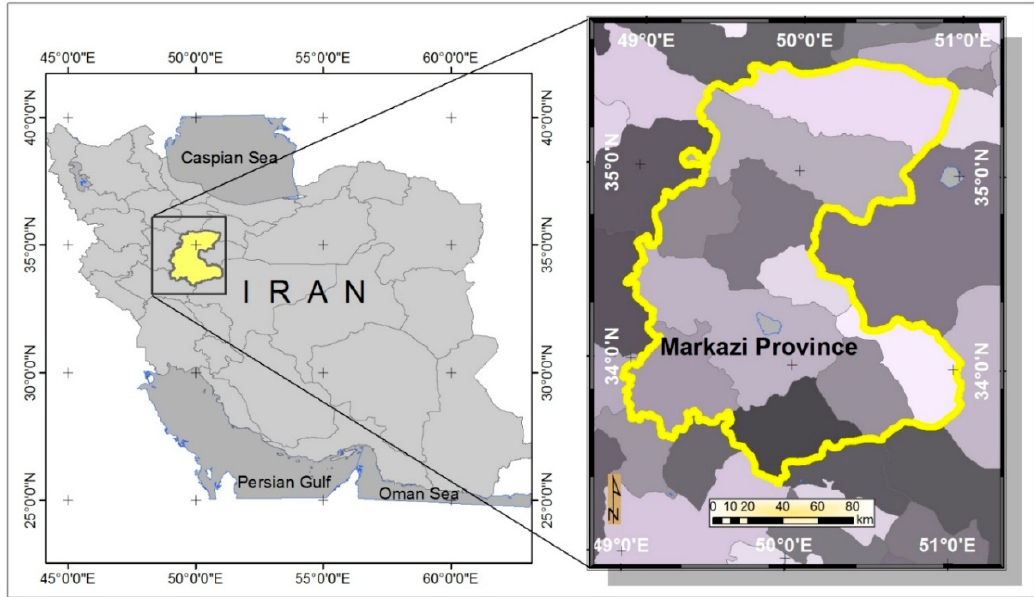
Figure 1. Location map of Markazi Province